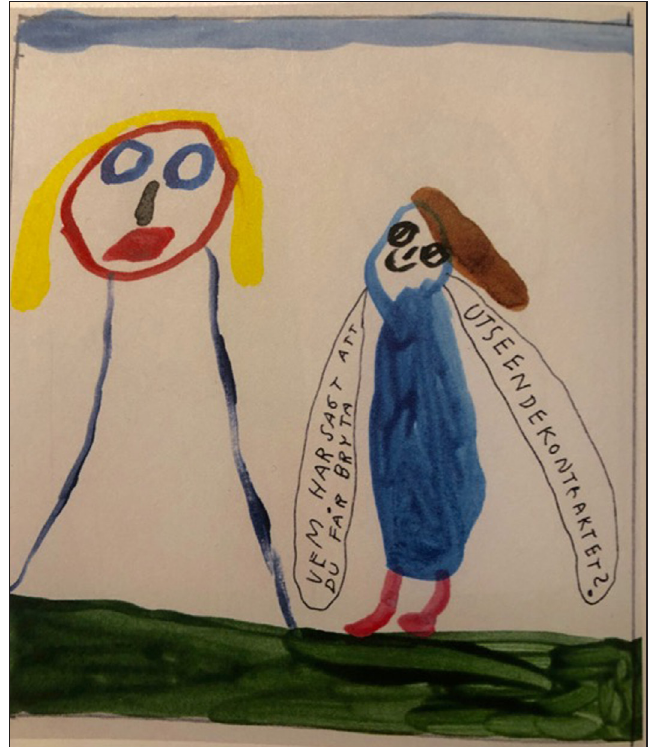
Figure 2: Freja Erixån (2019) Över min döda kropp. Stockholm: Kartago. © Freja